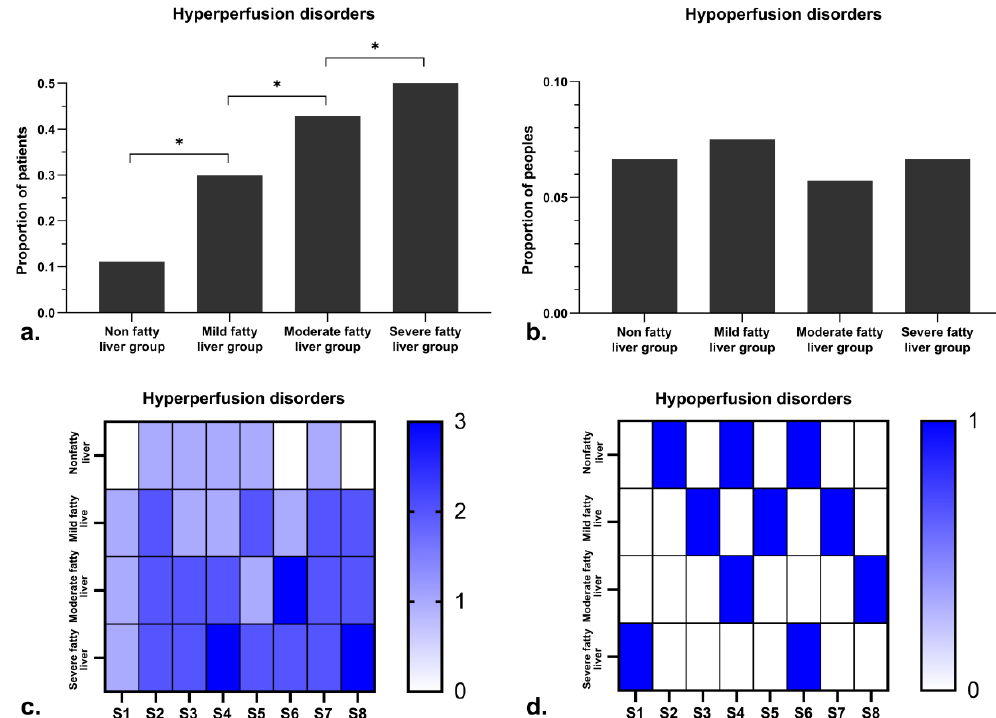
Figure 2. The proportion and number of abnormal perfusion foci in each group of patients and each liver segment. The proportions of patients with hyperperfused foci were significantly different between the nonfatty liver group and the fatty liver group ( a ), whereas the proportions of patients with hypoperfused foci were not significantly different between the nonfatty liver group and the fatty liver group ( b ). The number and distribution of hyperperfusion abnormalities ( c ) and hypoperfusion abnormalities ( d ) in each liver segment were not specific, and there was no statistical